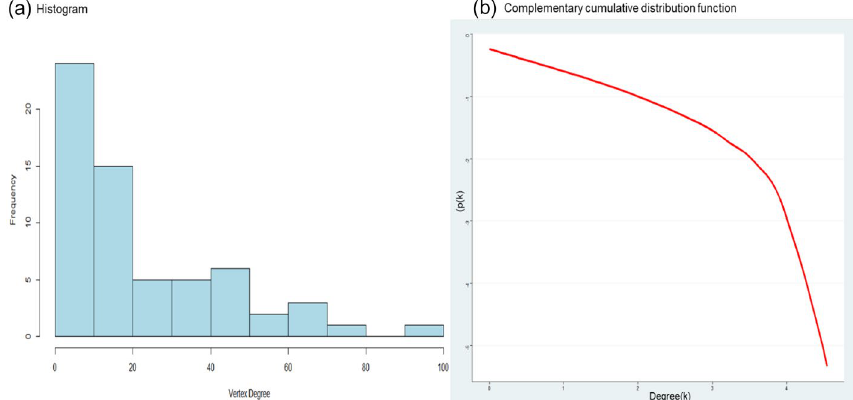
Fig. 2 Degree distribution of the Transport Equipment Industry. a Provides the histogram of the degree distribution. The Horizontal axis measures the number of links each country has and the frequency on the vertical axis reflects the number of countries with that degree. b Provides the complementary cumulative distribution in its log–log scale (Source: Own elaboration with EORA